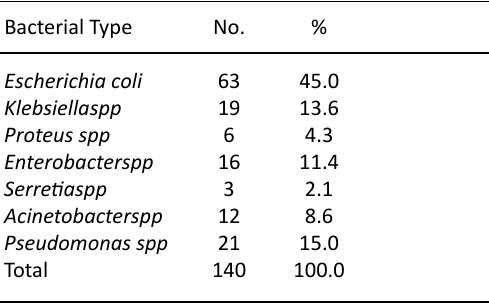
Table 1. Distribution of culture positive Bacterial Isolates Bacterial